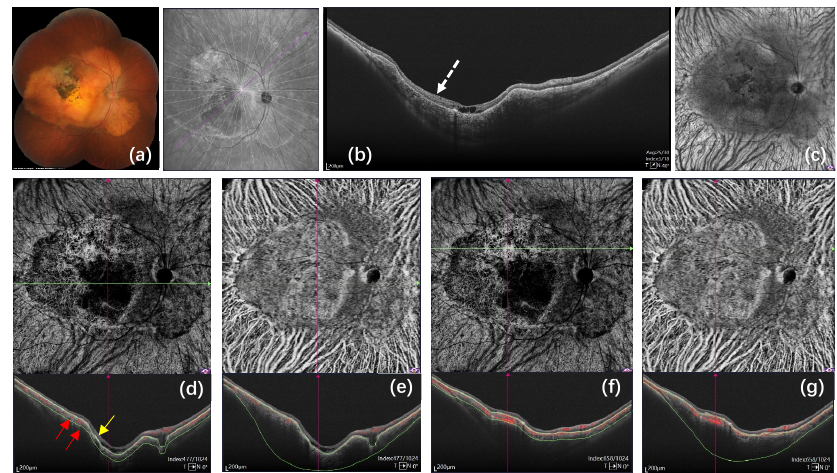
Figure 2. Multimodal imaging of patient 5 (see Table 1): ( a ) fundus photography shows a well-defined circumpapillary osteoma with macular involvement; ( b ) SS-OCT shows a region of speckled reflective dots, with obvious focal choroidal excavation (dashed arrow); ( c ) an en face image corresponding to ( g ) shows the clear border of the entire osteoma; ( d , f ) an SS-OCTA image of the choriocapillaris layer shows the blood flow signal of osteoma to be located mainly within the choriocapillaris and partly Sattler’s layer on a composite B-scan. Areas of overlying RPE hyperplasia and discontinuous or compressed choroidal vessels show no blood flow signal (yellow arrow). The hyporeflective tubular areas (red arrow) that were interpreted as intratumoral vessels did not show any blood flow signal; ( e , g ) SS-OCTA segmentation covering the entire border of the CO on aligned B-scan images shows the boundary of the tumor clearly demarcated from adjacent vessels of the choroidal Sattler’s layer and Haller’s layer.